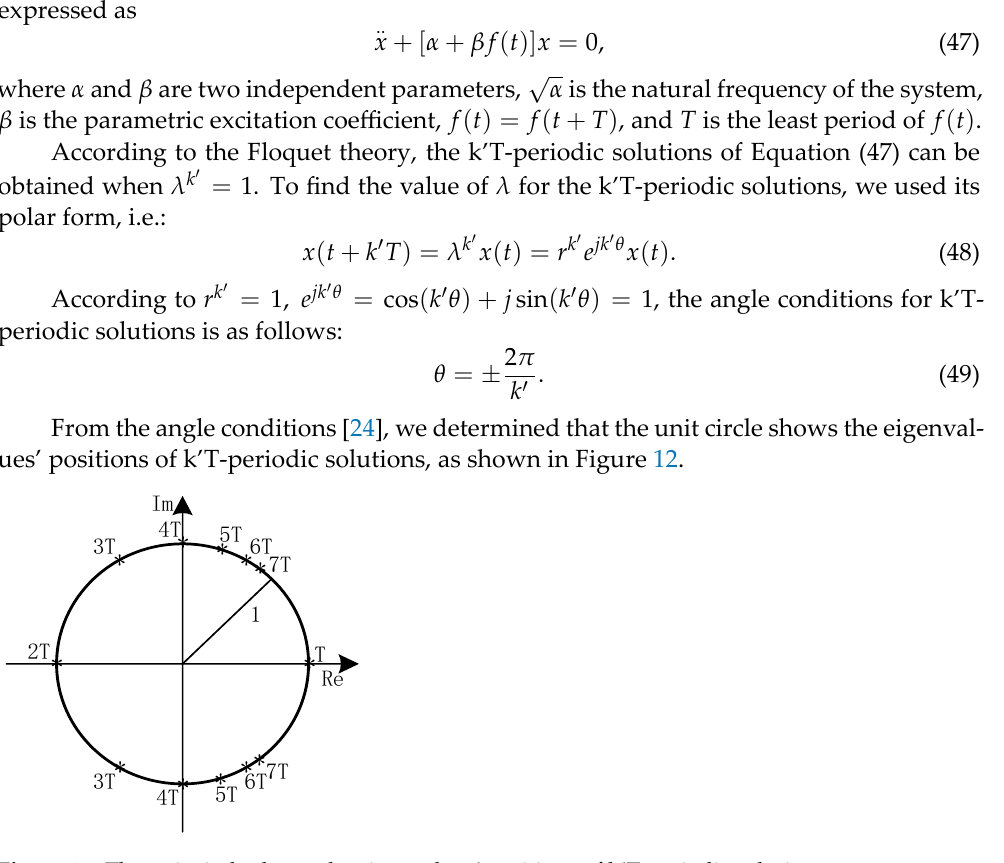
Figure 12. The unit circle shows the eigenvalues ’ positions of k’T -periodic